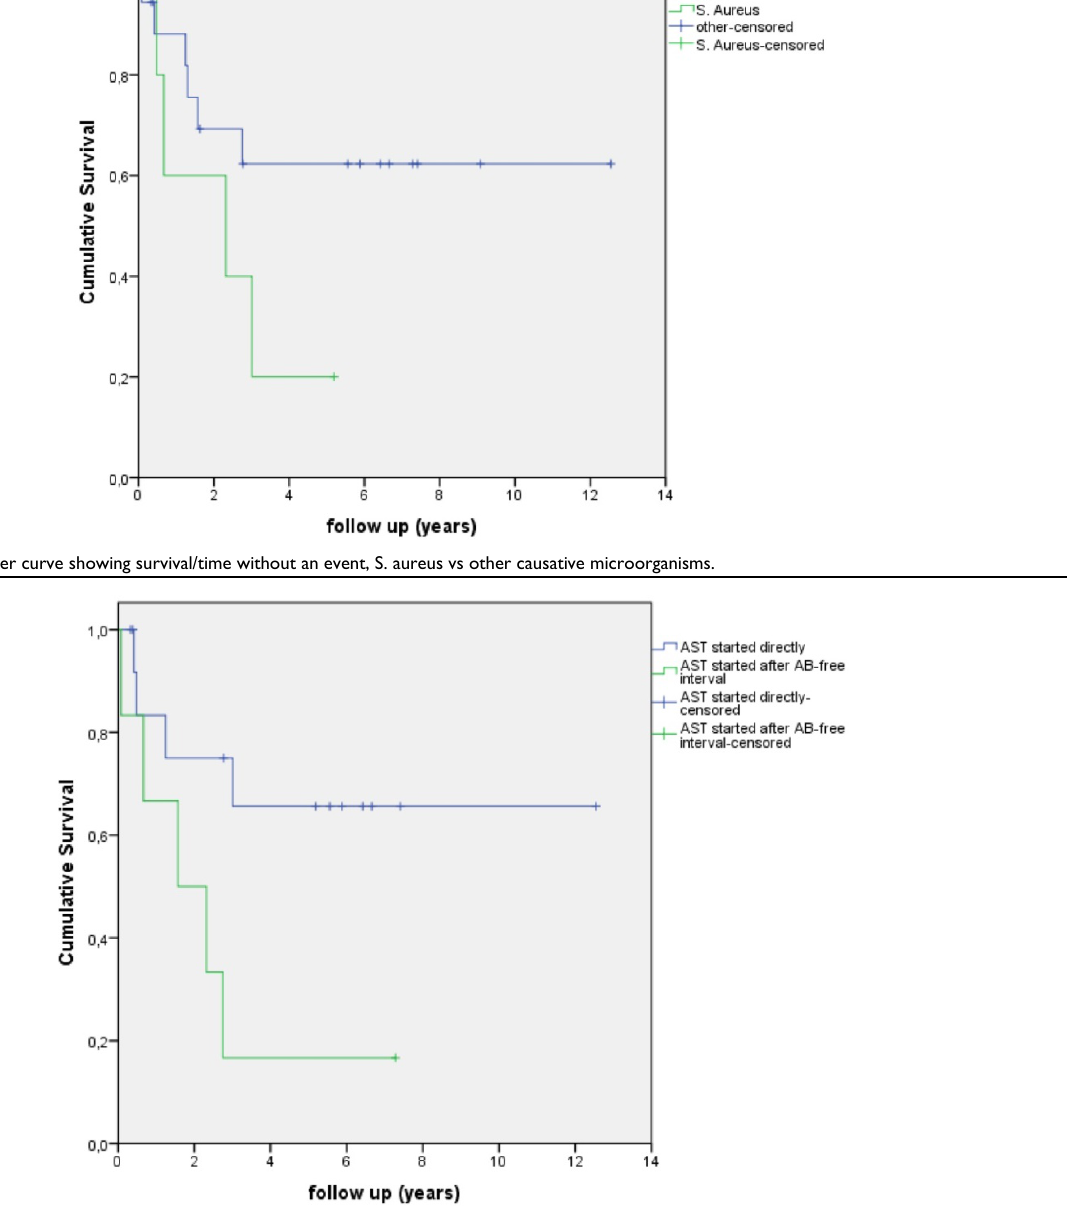
Figure 4. Kaplan-Meier curve showing survival/time without an event, AST started directly vs AST started after AB-free